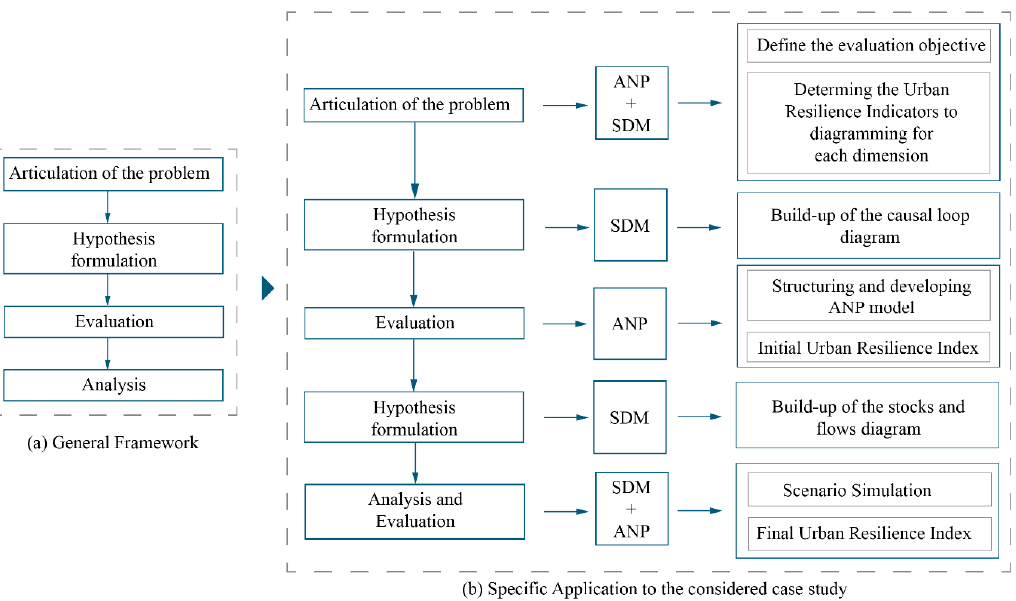
Figure 8. Structuring of the evaluation model.